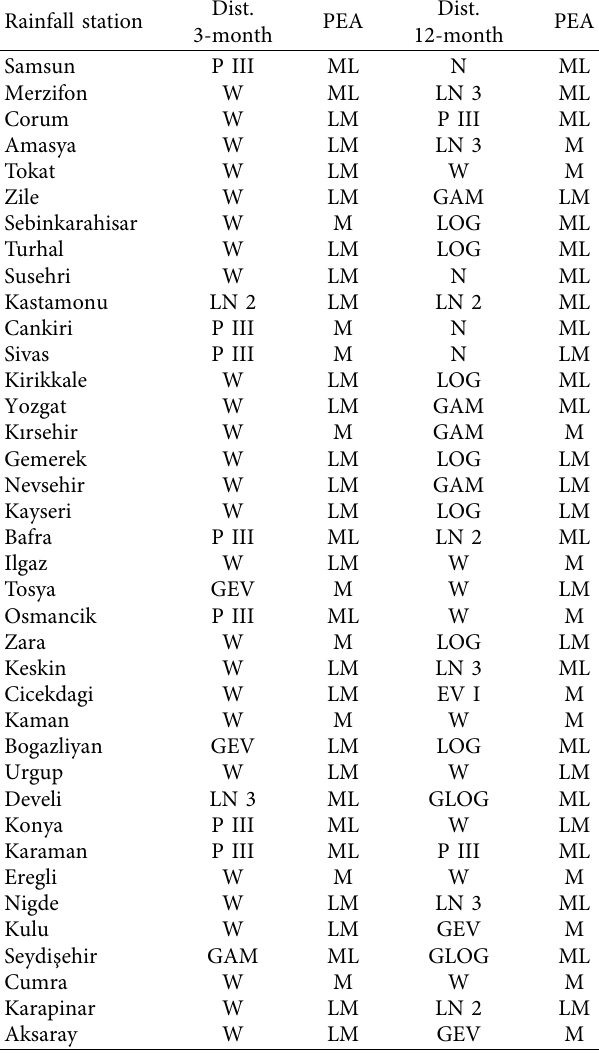
Table 4: Teoretical distribution models most approximately ft- ting the rainfall data of 3-month and 12-month for the sites. Rainfall station